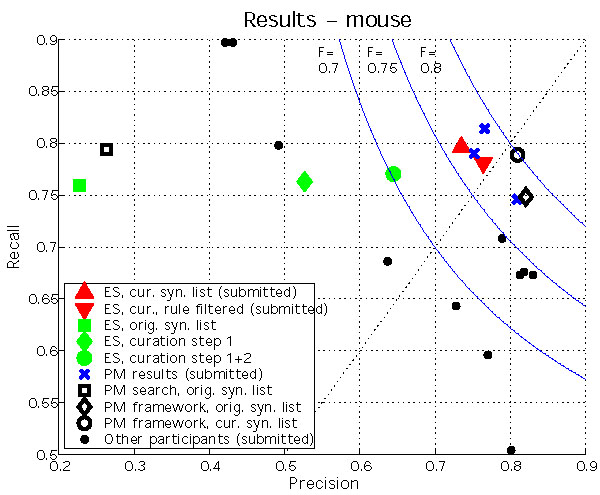
Mouse results. BioCreAtIvE task 1B results for mouse and the impact of curation on exact search and the ProMiner approach. ES: Exact search; PM: ProMiner; cur.: fully curated synonym list; orig. syn. list: original synonym list as provided by organizers. For the exact search, the submitted results were obtained with the fully curated synonym list and the fully curated synonym list with subsequent application of the rule-based post filter. The results of exact matching of the original synonym list, and lists obtained from the two intermediate curation steps are also shown. For ProMiner, the results of the approximate search alone (PM search) and the results of the ProMiner framework (i.e. approximate search plus filtering and disambiguation) with optimal parameter setting are shown. The submitted results (PM results) were obtained with the entire ProMiner framework, the same fully curated synonym list and different sets of parameters [12]. The fully curated synonym lists used for exact search and the ProMiner approach were the same except ambiguous synonyms.